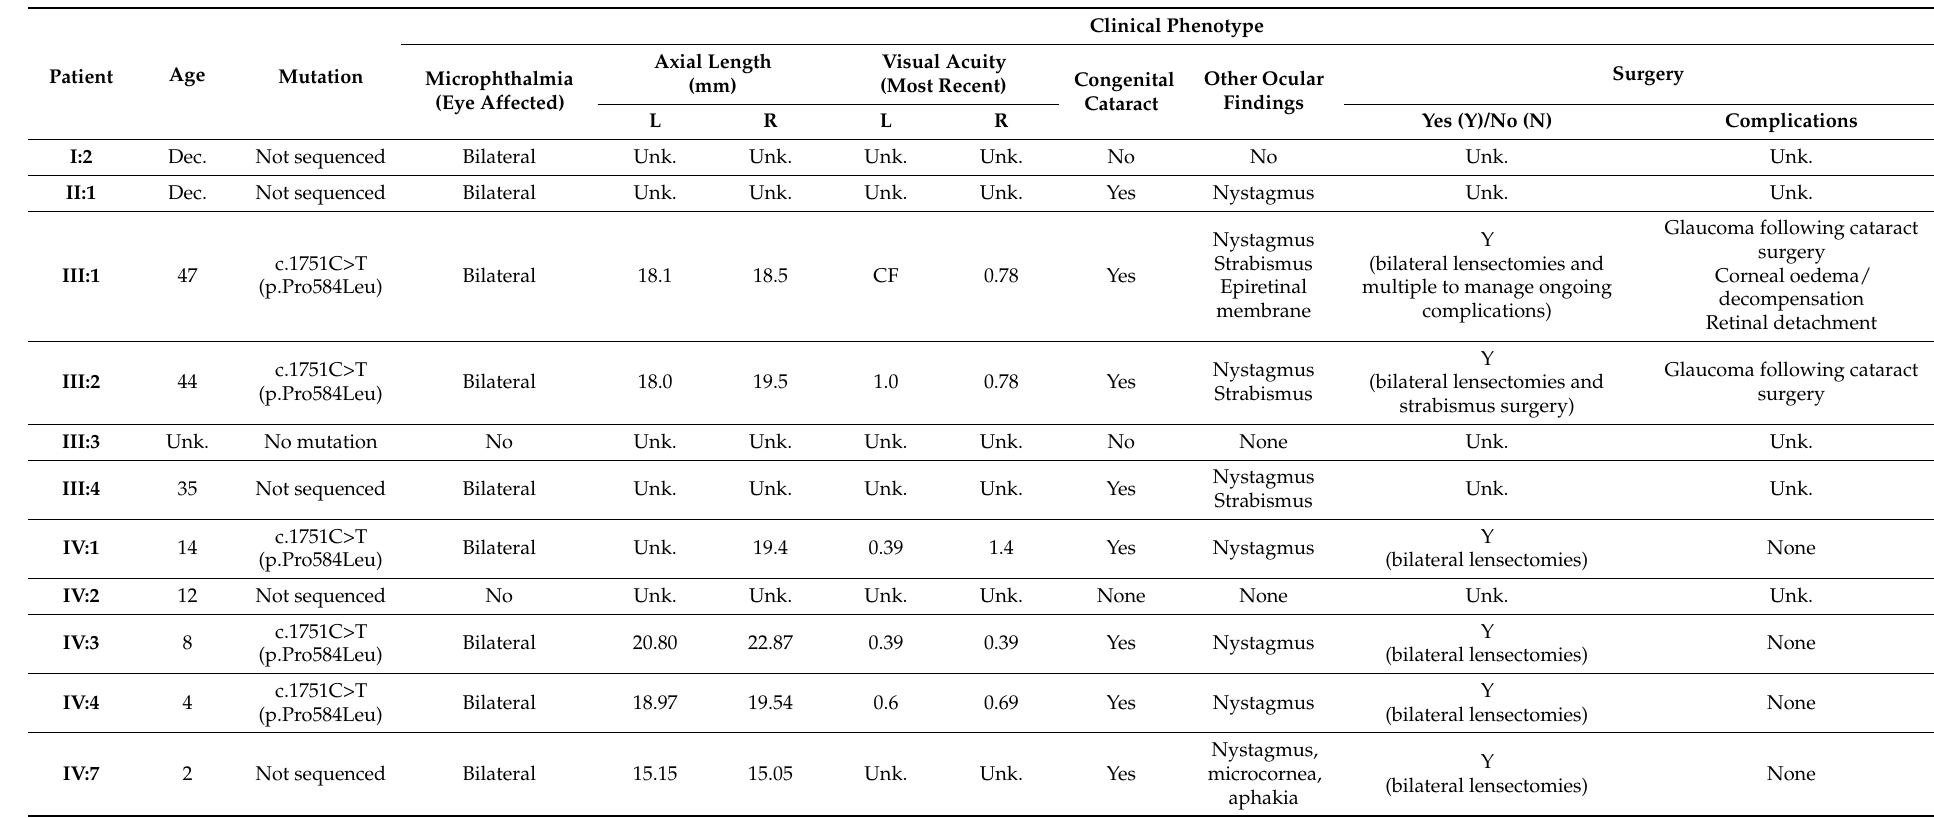
Table 1. Clinical phenotype data of four-generation family 1 with EPHA2 mutation c.1751C>T (p.Pro584Leu) identified through whole genome sequencing segregating with bilateral microphthalmia and congenital cataract phenotype.